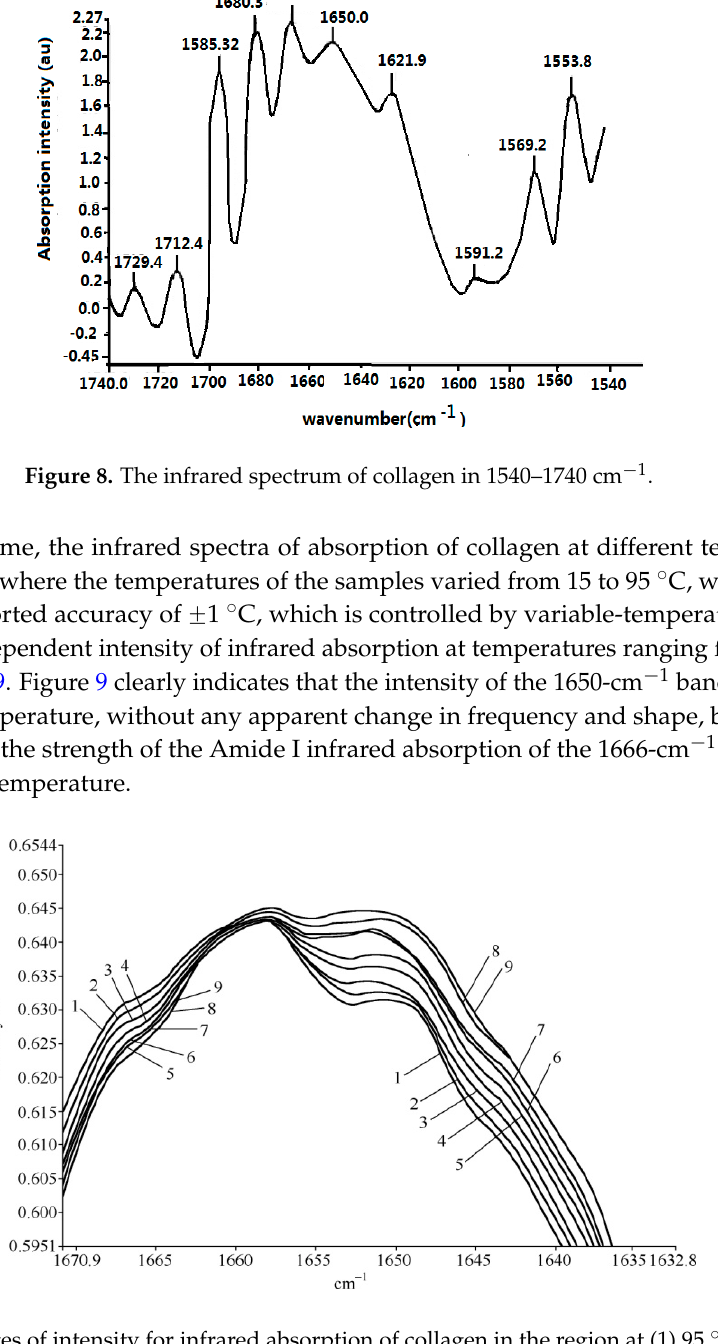
Figure 9. Changes of intensity for infrared absorption of collagen in the region at (1) 95 °C; (2) 85 °C; (3) 75; (4) 65 °C; (5) 55 °C; (6) 45 °C; (7) 35 °C; (8) 25 °C; and (9) 15 °C.